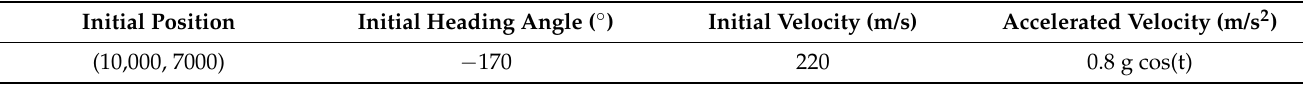
Table 2. The initial conditions of the